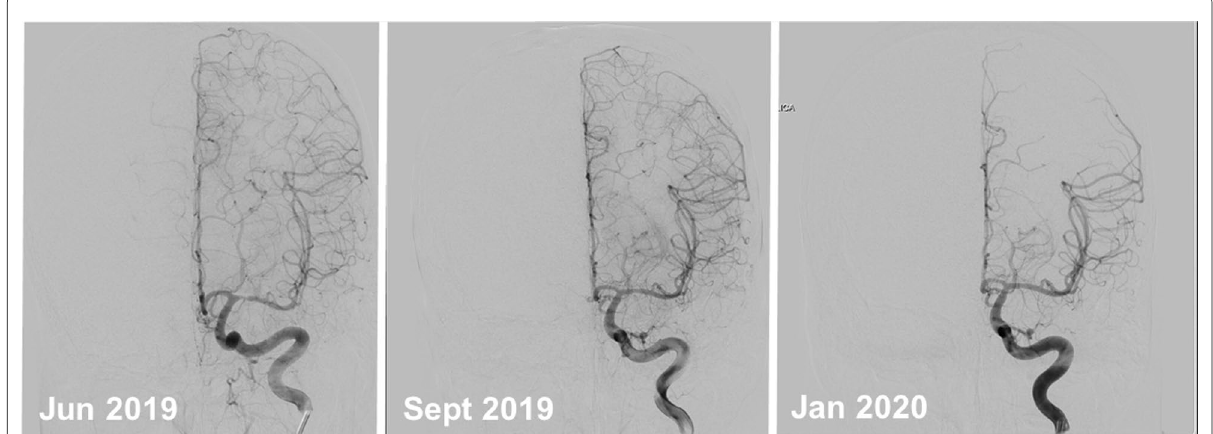
Fig. 2 Improvement of left-sided stenosis of middle cerebral artery in a patient treated with prednisolone and